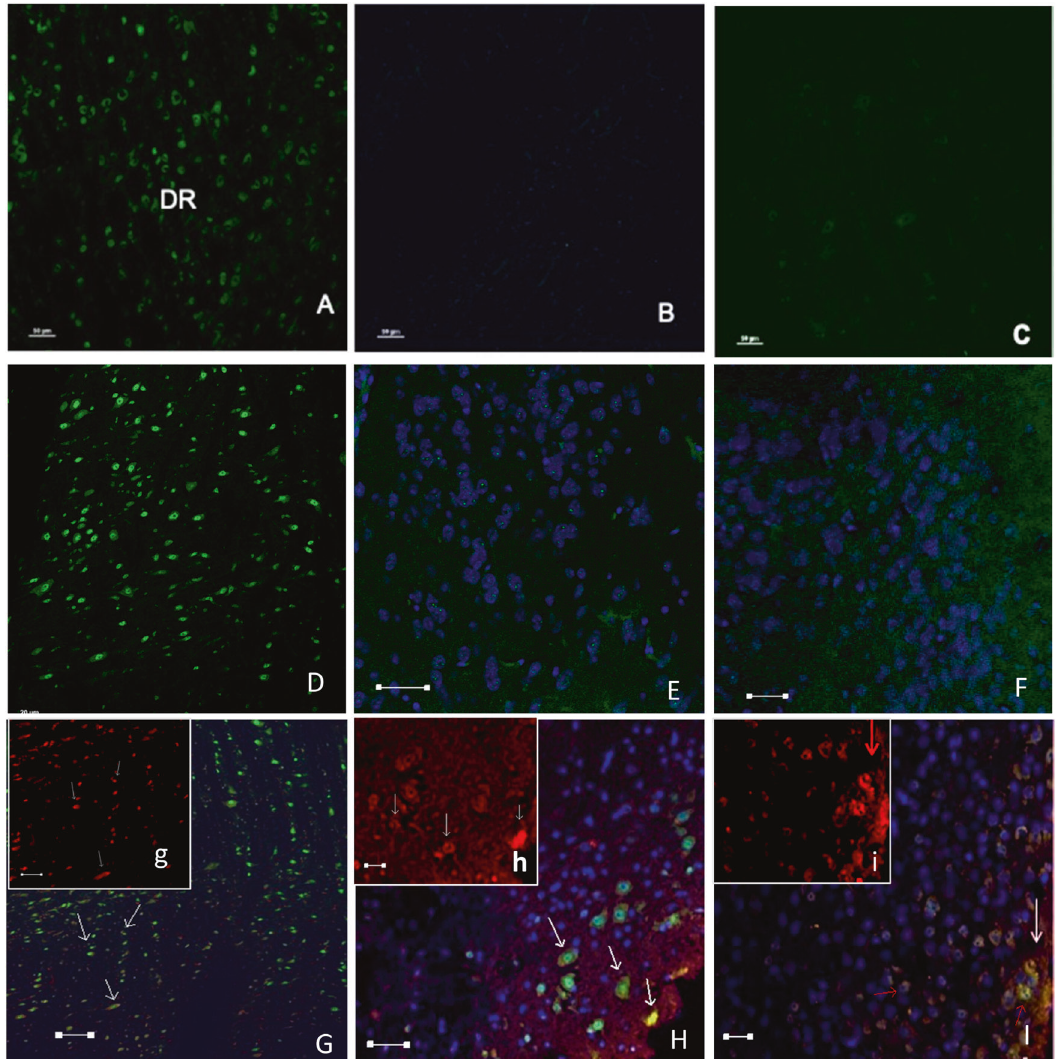
Fig. 4 Tph2 and FLAG immunodetection within the brainstem dorsal raphe nucleus, amygdala, and hypothalamus after the ocular administration of pIRES-hrGFP-1a-Tph2-FLAG to mice. Tph2 expression in non-transfected control mice is observed in the cytoplasm of neurons from the dorsal raphe nucleus of the brainstem ( A ) but not in the amygdala ( B ) and hypothalamus ( C ). In transfected animals although Tph2 is also expressed in the cytoplasm of neurons from the dorsal raphe nucleus ( D ) it can also be expressed within the nerve terminals (punctate) in both the amygdala ( E ) and hypothalamus ( F ). Tph2 (green) and FLAG (red) proteins were co-expressed (yellow) (arrows) in both the nuclei and cytoplasm of neurons in the dorsal raphe ( G ; g) and in the nerve terminals of the amygdala ( H ; h) and hypothalamus ( I ; i). Sagittal section. Scale bar: 50 mm in A , D and G ; and 20 μ m in B , C , E , F , H , h and